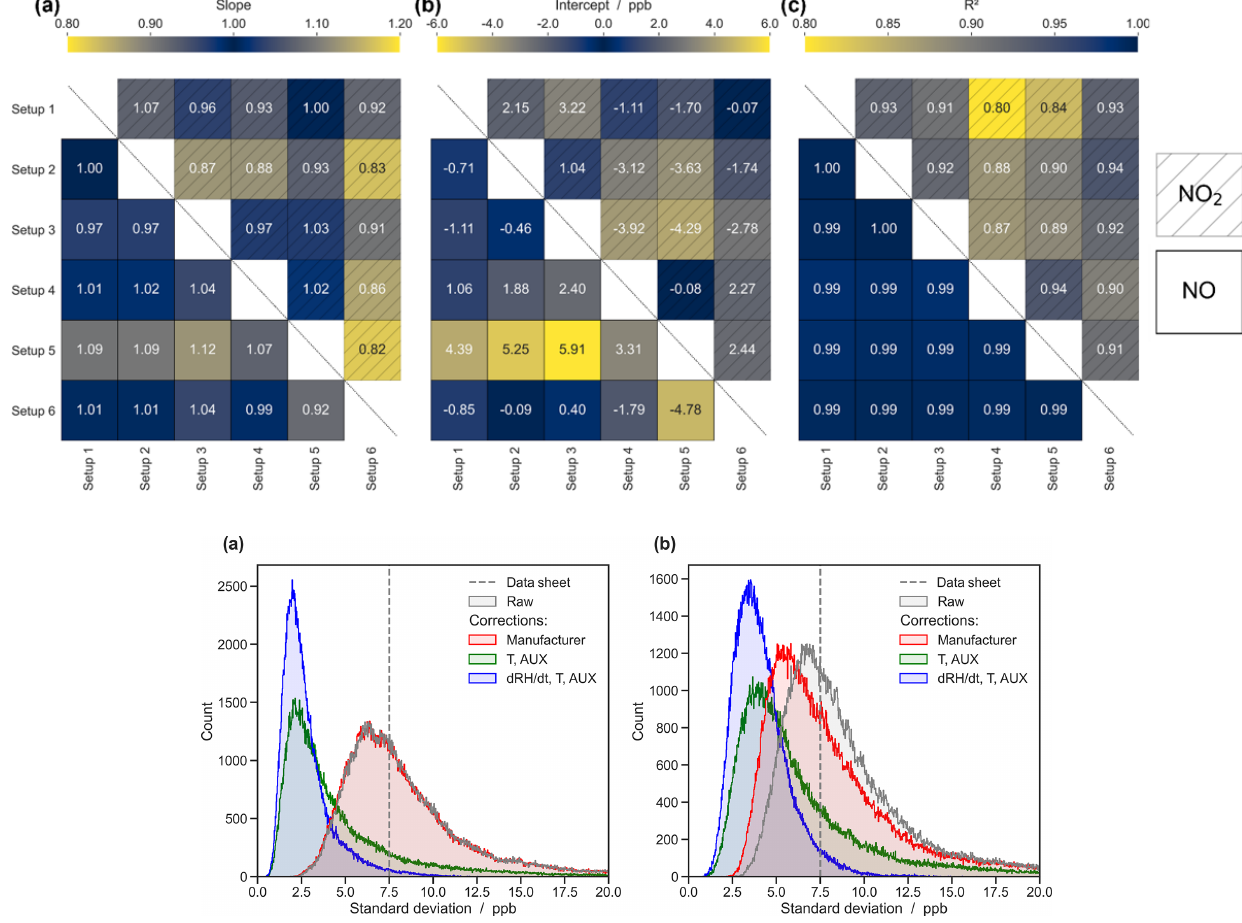
Figure 4. Distributions of standard deviations calculated inside 31s windows shown for (a) NO and (b) NO 2 sensors of setup no. 2 and filtered for flights above 100m to avoid engine exhaust peaks (number of data points = 270198). Adding dRH / d t to the correction procedure leads to a narrower distribution by reducing high changes in the signal on a short